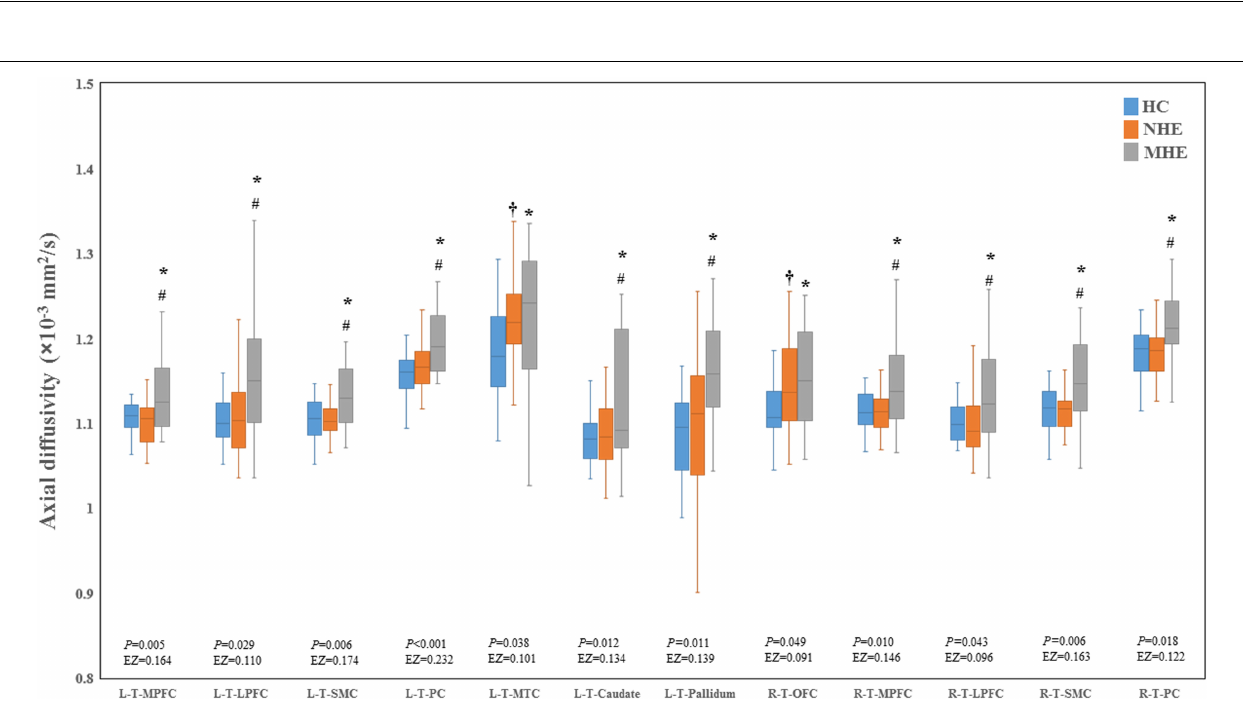
Frontiers in Neuroanatomy |